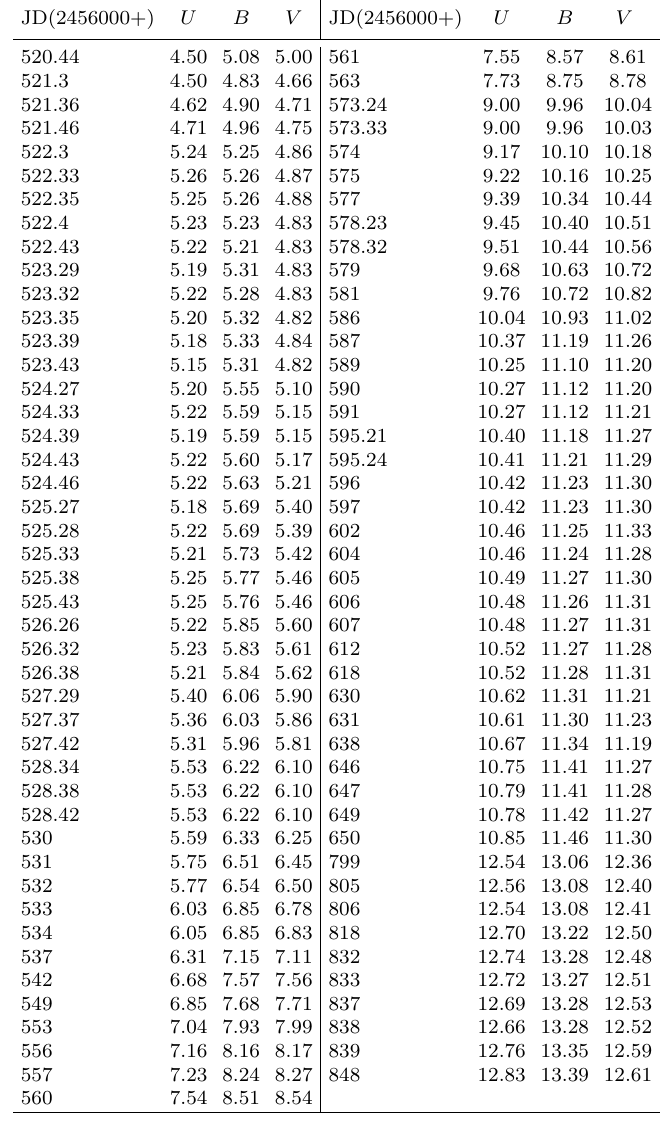
Table 1. UBV photometry of Nova Delphini